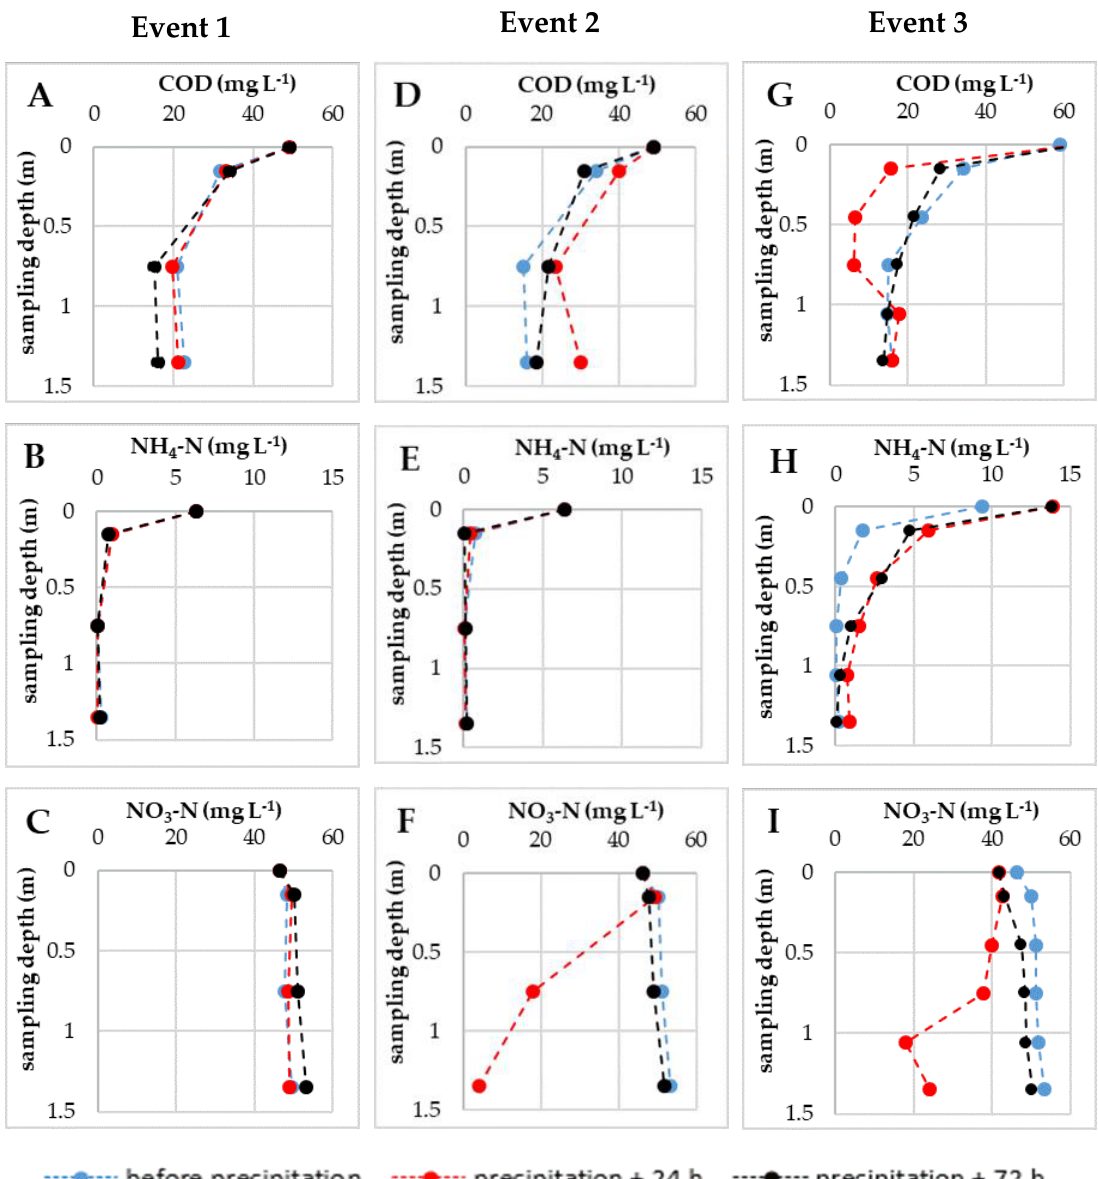
Figure 4. Vertical chemical oxygen demand (COD)-concentration profiles, vertical NH4-N concentration profiles, and vertical NO3-N concentration profiles for soil 2 before and 24 h and 72 h after the precipitation event 1 ( A – C ), event 2 ( D – F ), and event 3 ( G – I ).